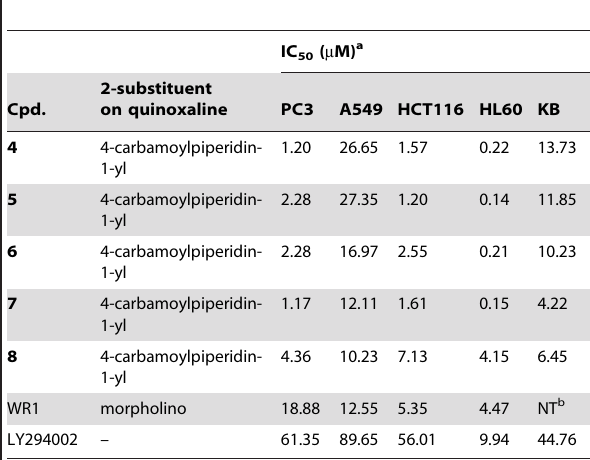
Table 2. Antiproliferative activity of piperazinylquinoxalines (9–13).